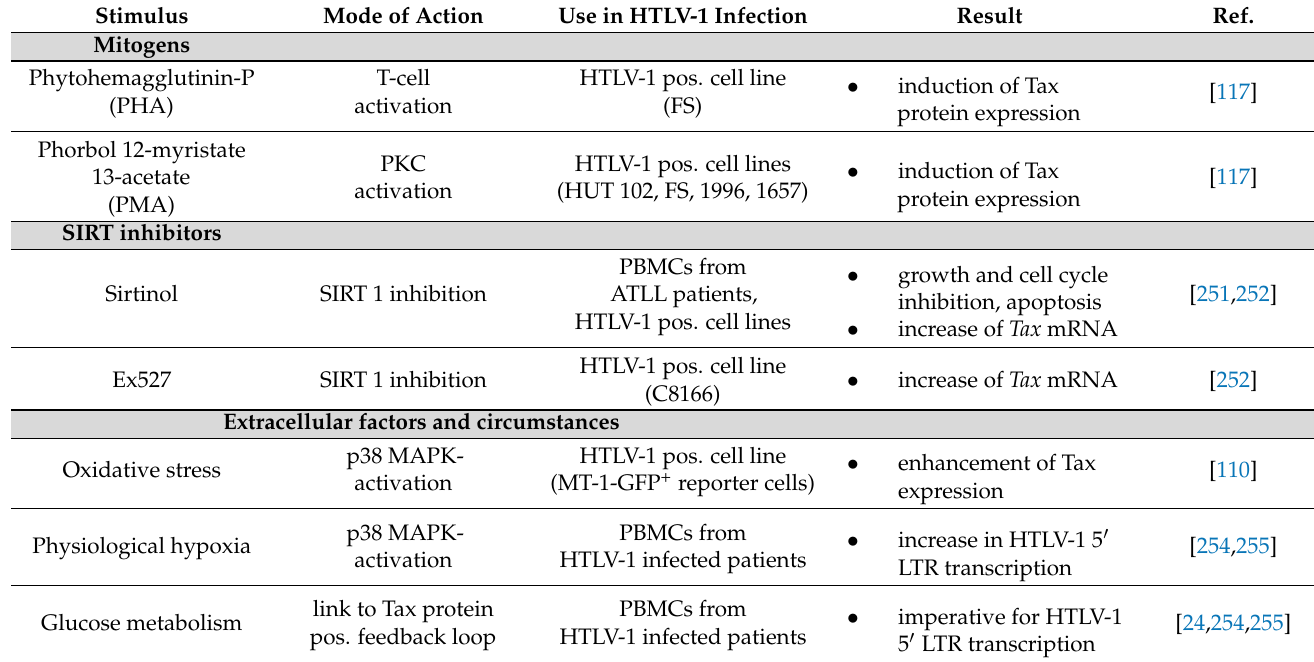
Table 3. Diverse stimuli that are involved in HTLV-1 latency reversal and transcriptional